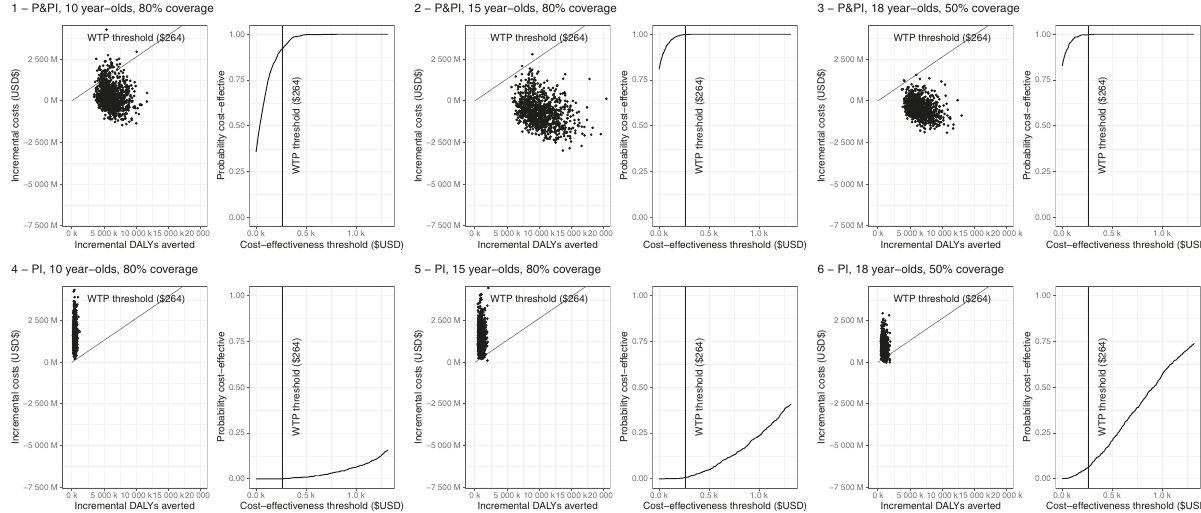
Fig. 2 Cost effectiveness planes showing incremental cost-effectiveness ratios for vaccine introduction scenarios in India. Top row (panels 1 – 3) shows cost-effectiveness planes (scatter plot) and cost-effectiveness acceptability curves (line graph) for three scenarios with pre- and post-infection vaccine ef fi cacy. Bottom row (panels 4 – 6) shows cost-effectiveness planes and cost-effectiveness acceptability curves for three scenarios of post-infection-only vaccine ef fi cacy. P&PI denotes vaccine with pre- and post-infection. PI denotes vaccine with post-infection ef fi cacy only. DALY disability-adjusted life year, USD United States Dollars, WTP willingness to